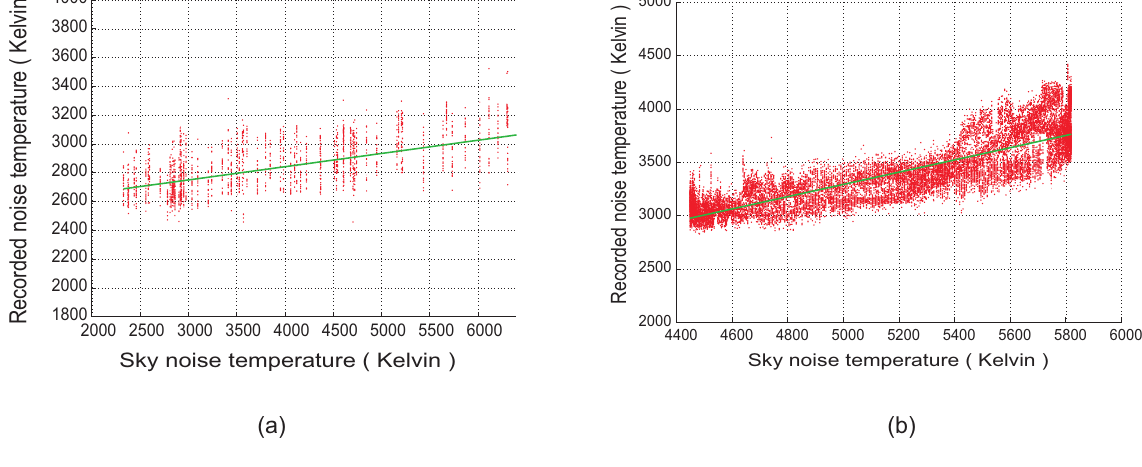
Fig. 3. The linear regression fit between the recorded sky noise temperature values and the actual sky noise values for a sidereal day in the case of the Resolute Bay radar. While (a) corresponds the Main-Mode radar, part (b) corresponds to the Quartet-Mode. In order to get a best line fit, a robust linear fitting method was